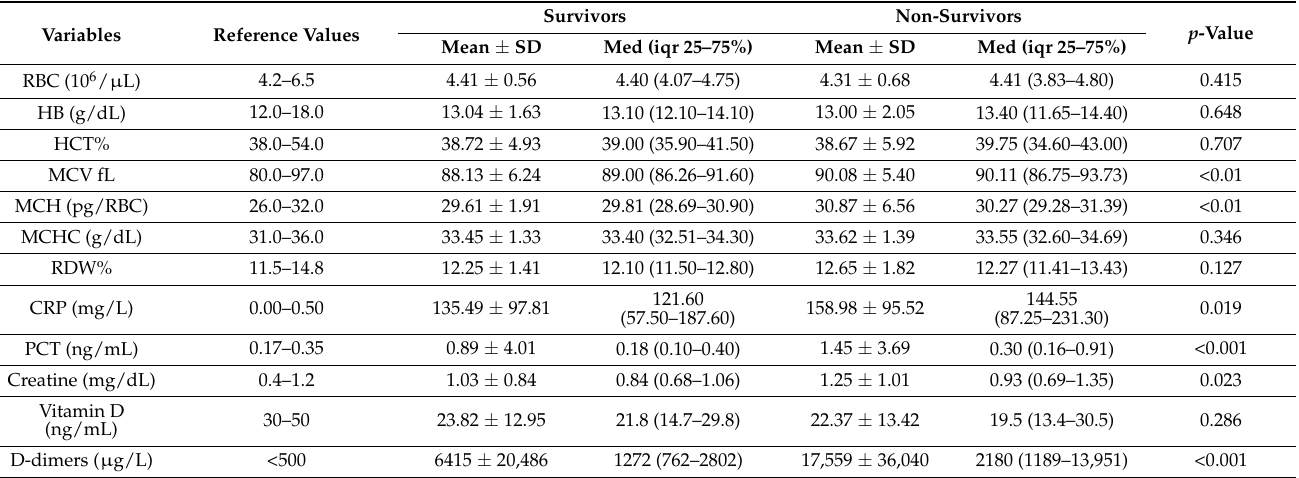
Table 2. Haematological and biochemical